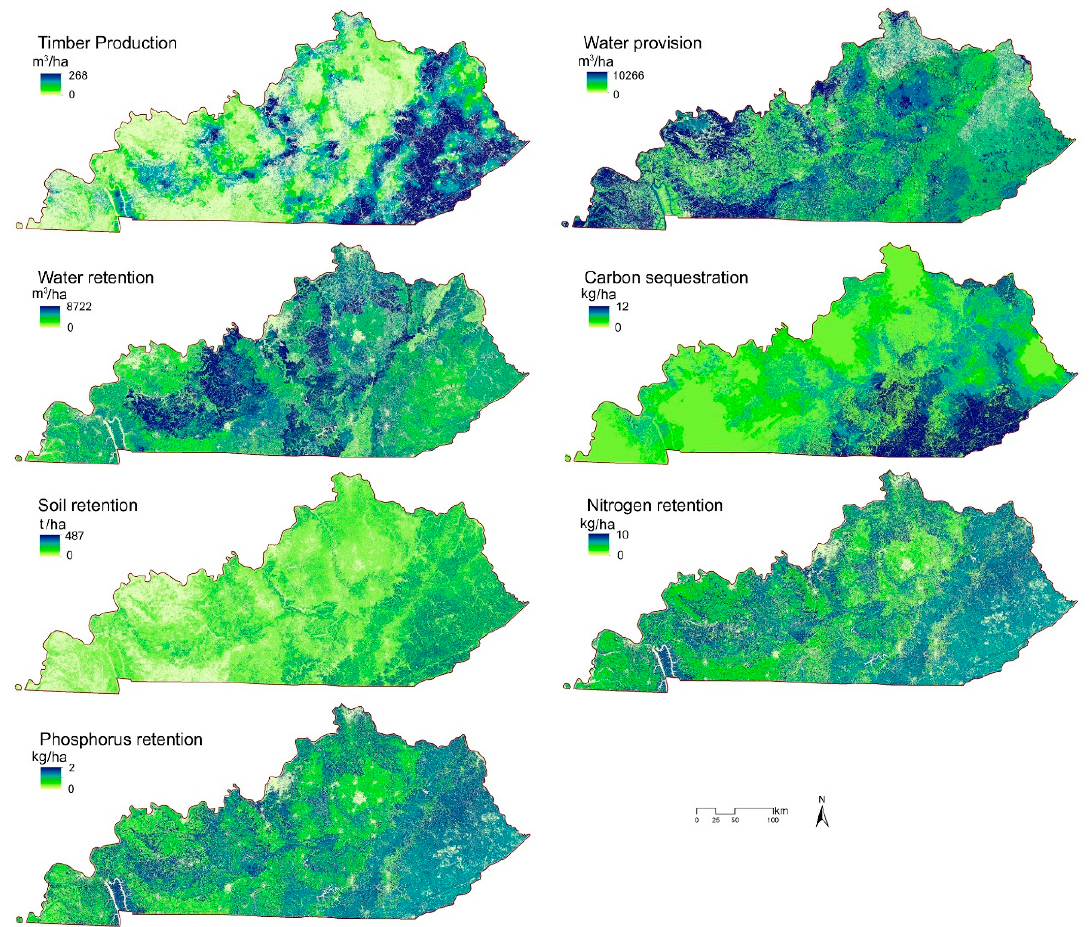
Figure 3. Spatial distributions of seven ecosystem services shown in quintiles.